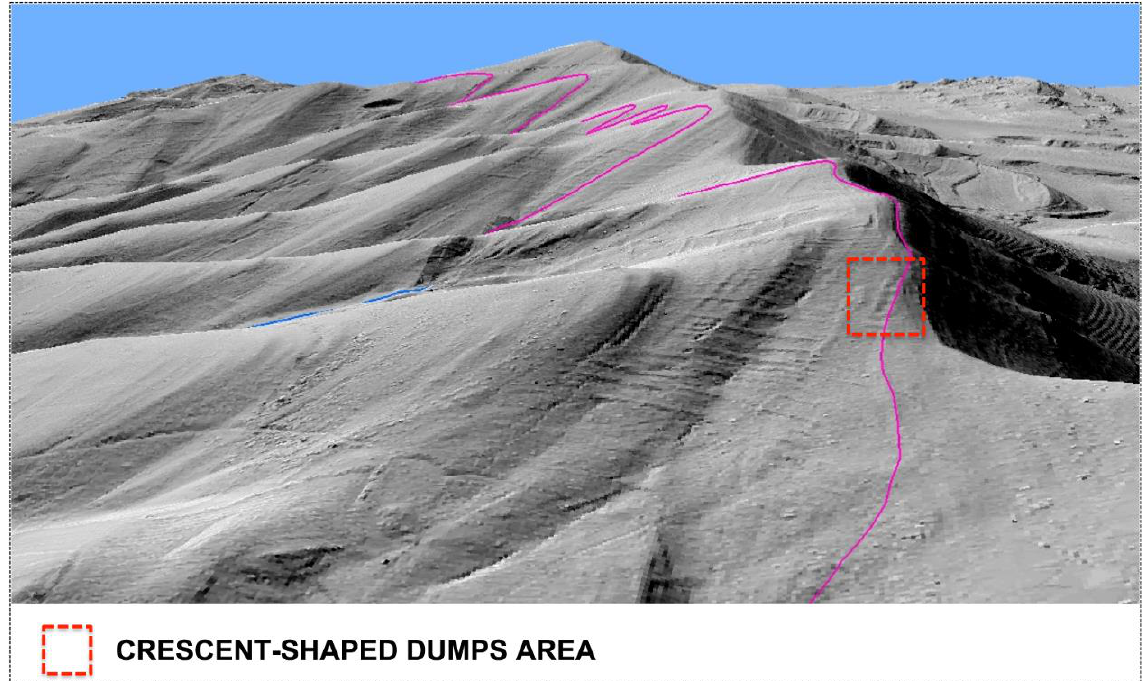
Figure 2. 3D Model of “Sierra de Araico” with the line of the nodular flint layer. The red square marks the location of the excavation with the crescent-shaped